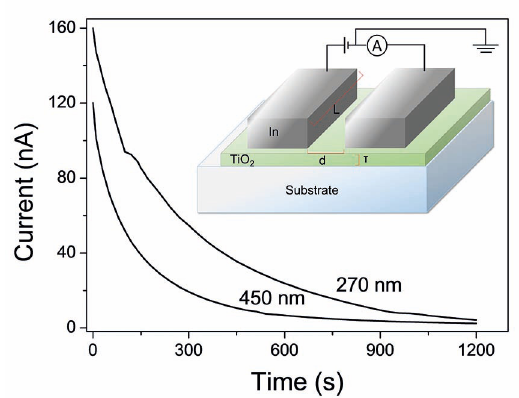
thin films, with Figure 6. Decay of photoinduced current in TiO 2 fixed potential of 20V and excitation with distinct light sources for 5 minutes. LED source: 15W, deuterium source: 30 W (previous to the interference filter). A very quick response was obtained, which sharply increases sample conductivity at the end of the excitation. Inset shows sample layout, with electrical connections and dimensions: film thickness (τ), distance (d) and width (L) of the